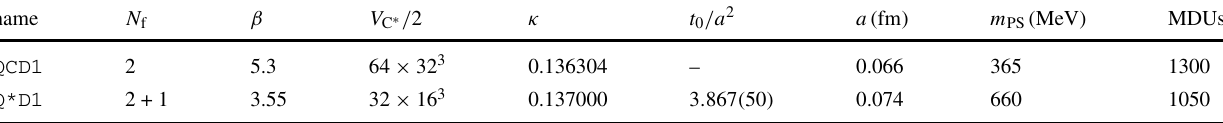
Table 1 Details of test runs employing C ∗ boundary conditions in 3 spatial directions, and periodic boundary conditions in the temporal direction. Note that due to the C ∗ boundary conditions, the global (sim- use the tree-level improved Symanzik gauge action (LW) for the SU ( 3